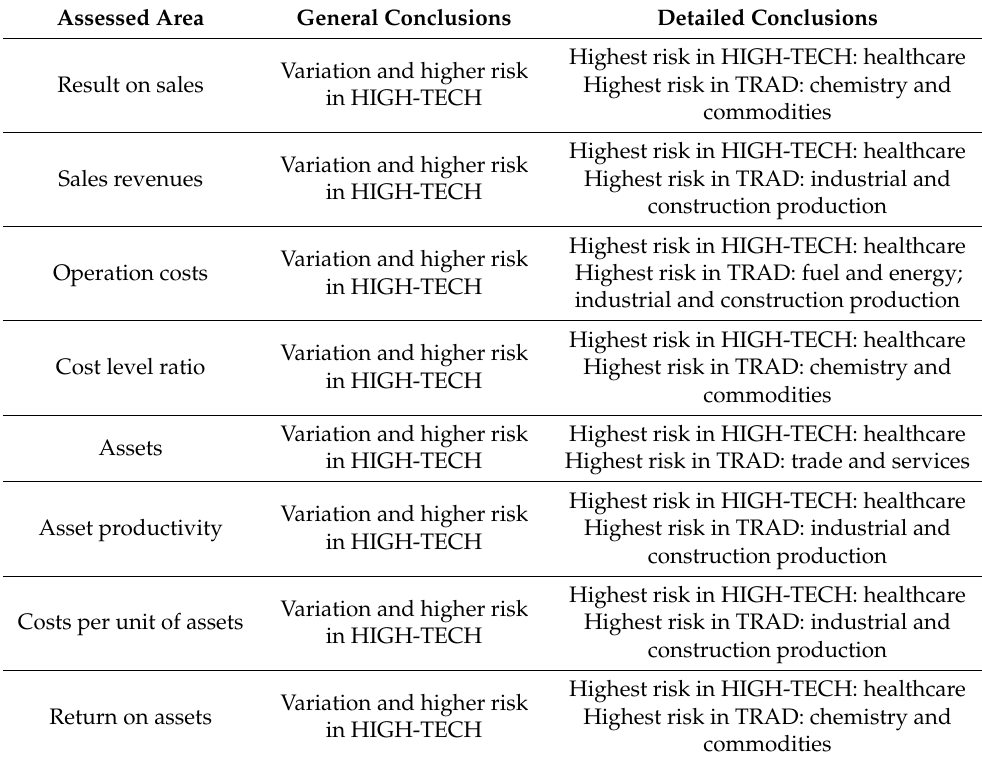
Table 2. Comparison of the risks in different sectors and assessment